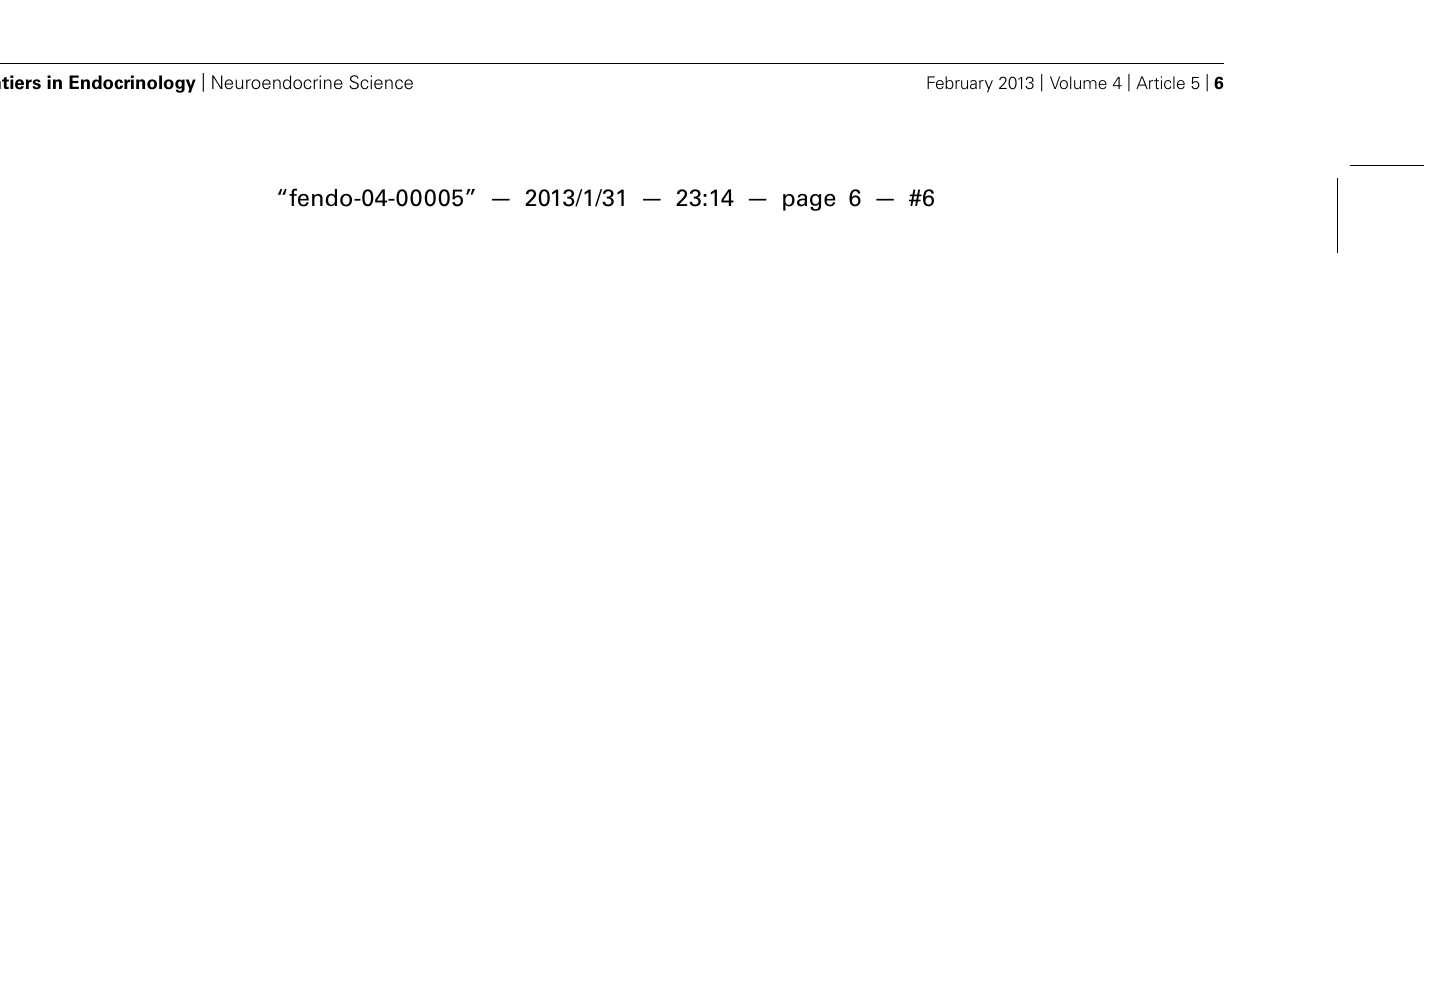
Frontiers in Endocrinology | Neuroendocrine